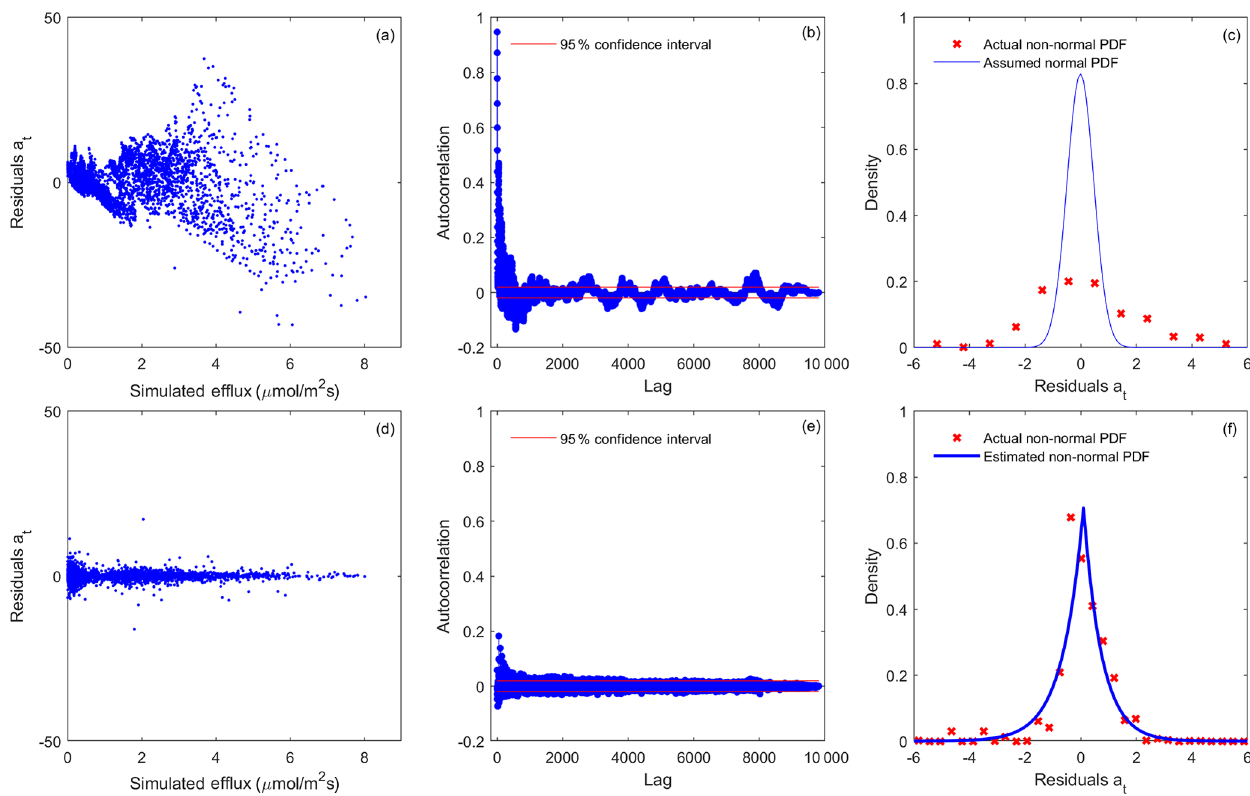
Figure 3. Residual analysis of the best realization (among multiple MCMC realizations) for model 6C using the (a–c) SLS and (d–f) WSEP- AC data